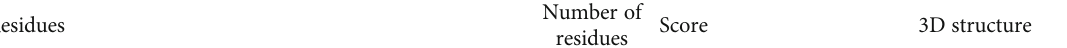
Number of Score 3D residues